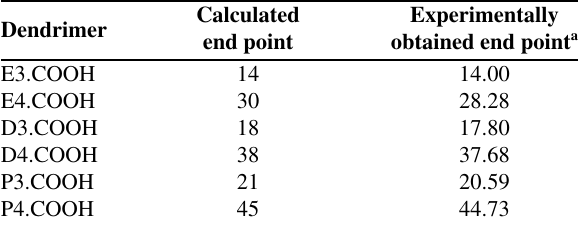
Table 3. Number of amine groups on carboxyl-terminated PAMAMs available for binding with Cu 2+ ions. Dendrimer